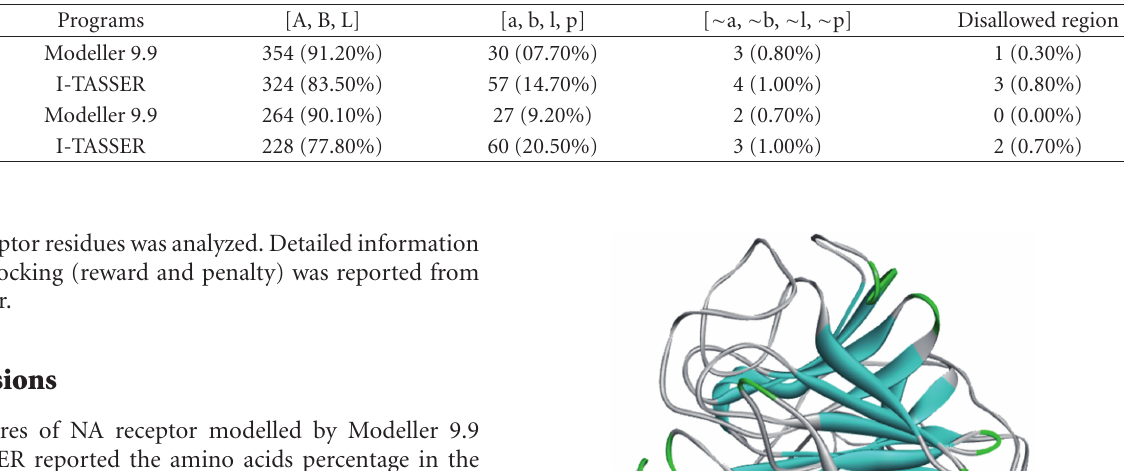
Table 2: Model evaluation statistics of NA and HA by PROCHECK NT standalone version.